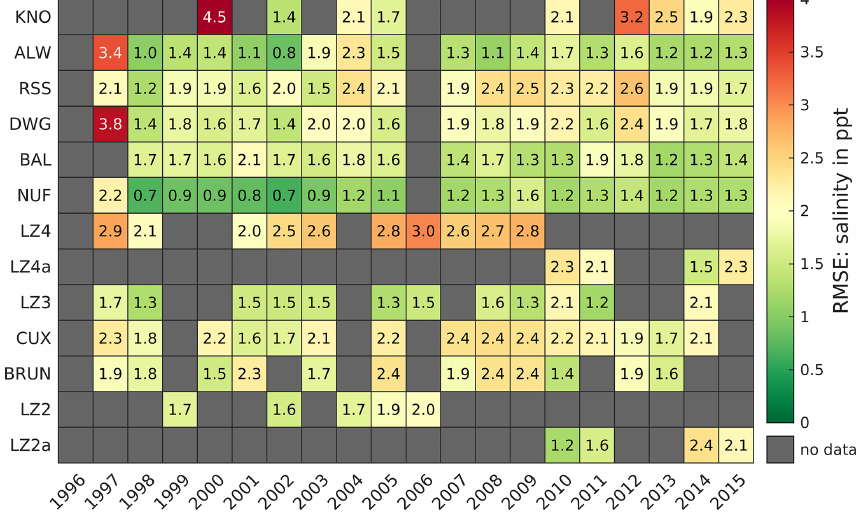
Figure 15. Root mean square error (RMSE) of the salinity in parts per thousand between 1996 and 2015 at representative